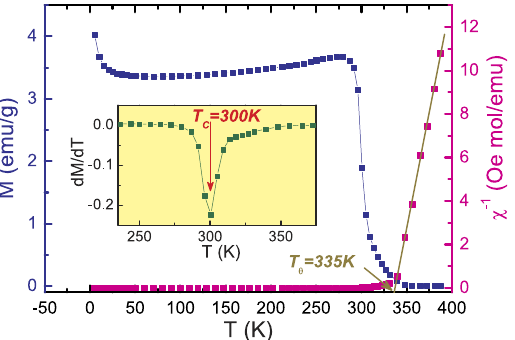
Figure 1. Left axes: Temperature dependence of magnetization measured at H = 100 Oe for La 0.6 Er 0.1 Sr 0.3 MnO 3 . Right axes: Inverse susceptibility χ − 1 dependence of temperature and the solid line represents the fitting data according to the Curie-Weiss law. Inset shows the plots of dM/dT versus